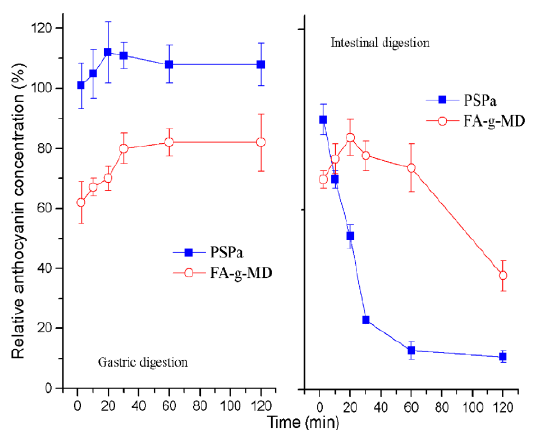
Figure 2. Time-dependent relative anthocyanin concentration in simulated gastric digestion and simulated intestinal digestion after incubation of native ANC and microcapsules produced by FA-g-MD. The values are expressed as mean ± SD (n = 3).